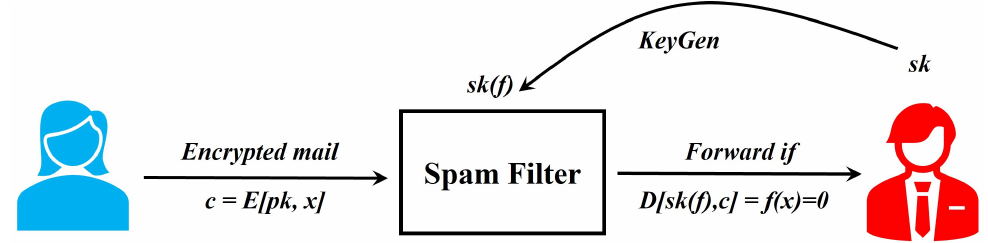
Figure 5. Functional encryption—spam filtering on encrypted